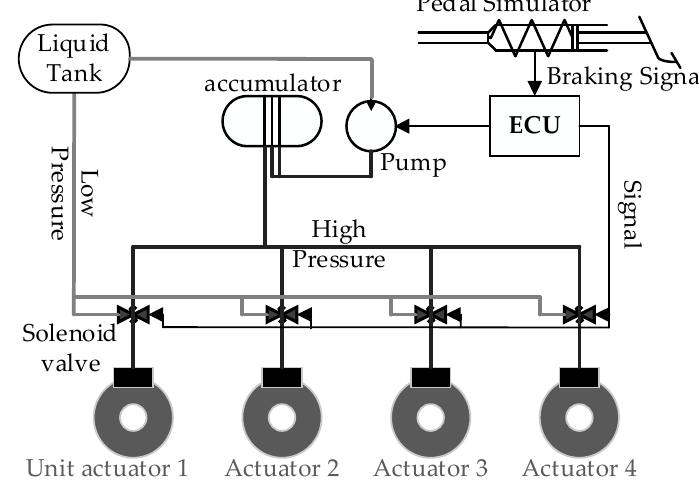
Figure 3. The structure and composition of electro-hydraulic brake (EHB).